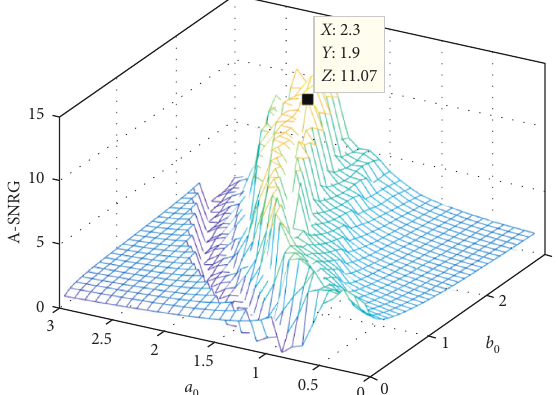
Figure 3: Three-dimensional diagram of the traditional symmetric bistable system SR adaptive optimization driven by trichotomous